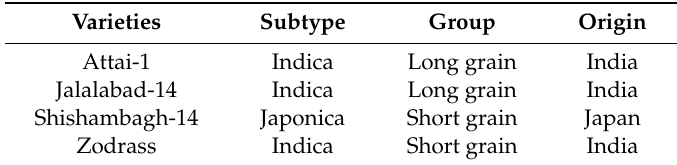
Table 1. List and description of the selected rice varieties. Varieties Subtype Group Origin